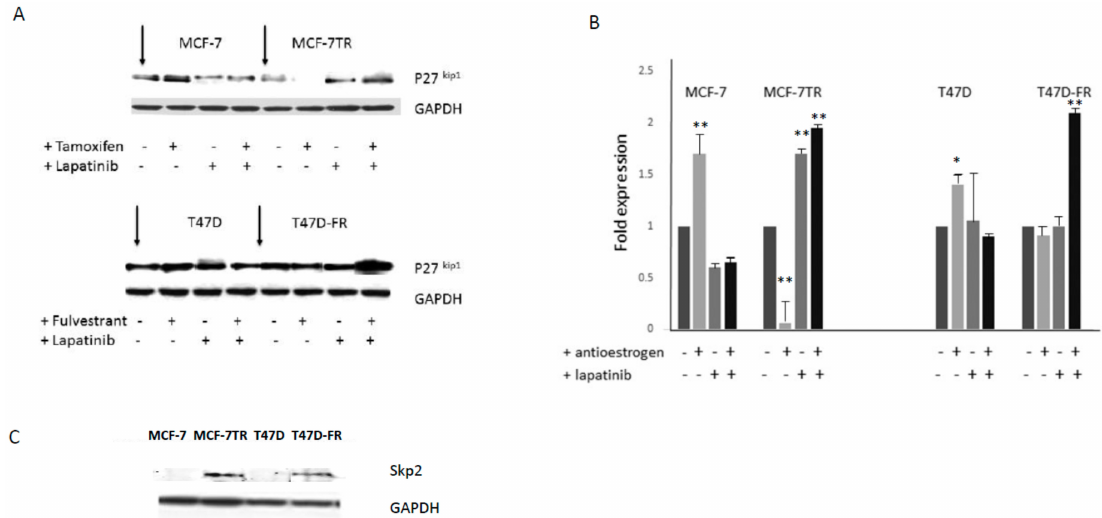
Figure 5. ( A ) Levels of p27 kip1 expression in drug-sensitive and -resistant MCF-7 and T47D breast cancer cell lines in the absence or presence of the 5 µ M lapatinib and anti-oestrogen therapy, with densitometry levels shown ( B ). ( C ) Constitutive expression of Skp2 in breast cancer cell lines. Representative Western blot data obtained from whole-cell lysates separated by SDS-PAGE, immunoblotted onto PVDF membranes before immunodetection ( n = 3). Expression levels were set as 1.0 (control cells) using densitometric analysis and are then shown in response to the various drug treatments relative to each control: * p < 0.05; ** p <